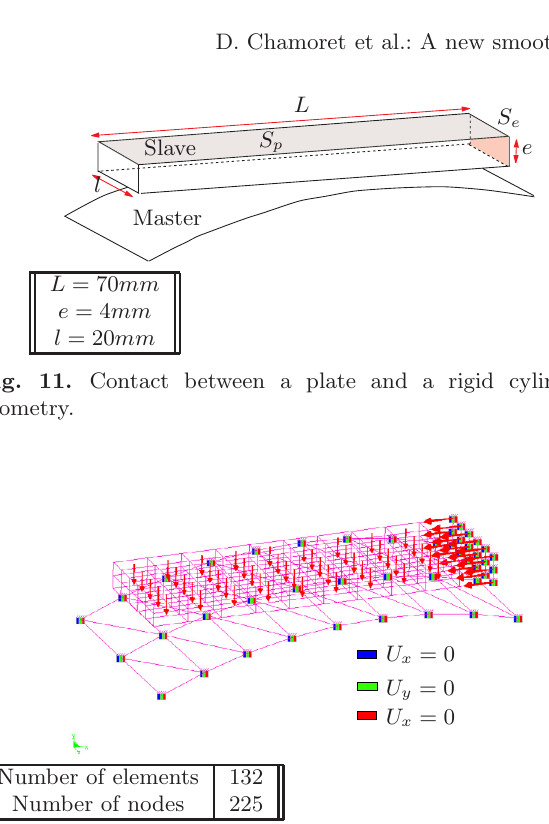
Fig. 12. Contact between a plate and a rigid cylinder: finite element model.